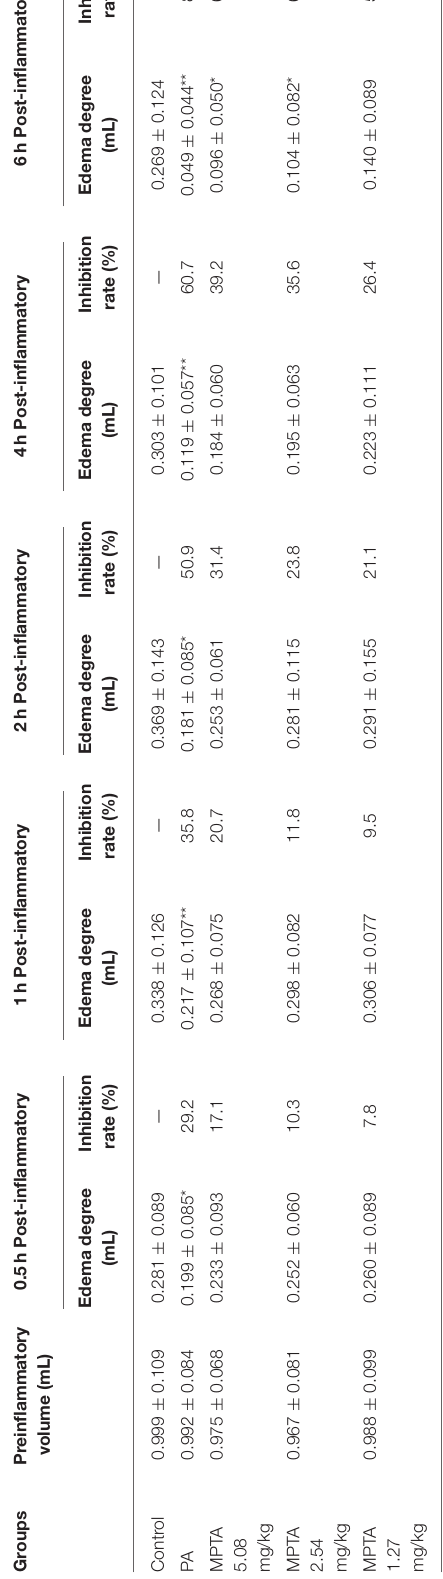
TABLE 3 | Effect of MPTA on auricular edema in mice ( n = 10). Groups Left ear